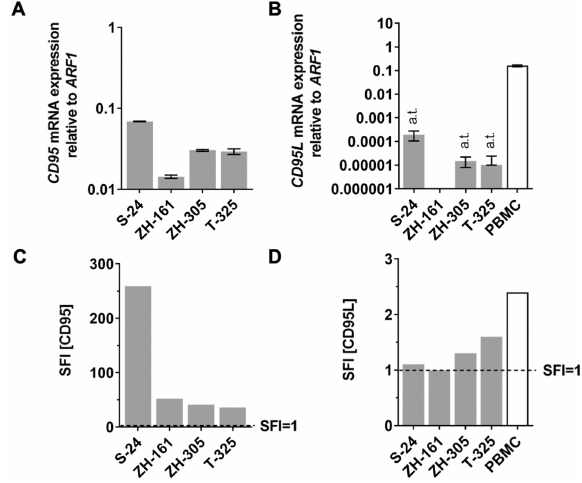
Fig. 1 CD95 and CD95L expression in human GIC in vitro. A , B S- 24, ZH-161, ZH-305, or T-325 human GIC were assessed for expression of CD95 or CD95L mRNA by RT-qPCR using primers targeting all known protein-coding CD95 or CD95L transcript variants and ARF1 as an internal control. Phorbol myristate acetate (10 ng/ml) and ionomycin (500 ng/ml)-activated peripheral blood mononuclear cells (PBMC) served as a positive control for CD95L expression detection. RT-qPCR data are expressed as mean and SD. a.t., above the threshold, indicates C T values above the reliability threshold of 32. C , D Cell surface protein levels were assessed by fl ow cytometry. Speci fi c fl uorescence indexes (SFI) were calculated by dividing the median fl uorescence intensities of the experimental antibody and the isotype